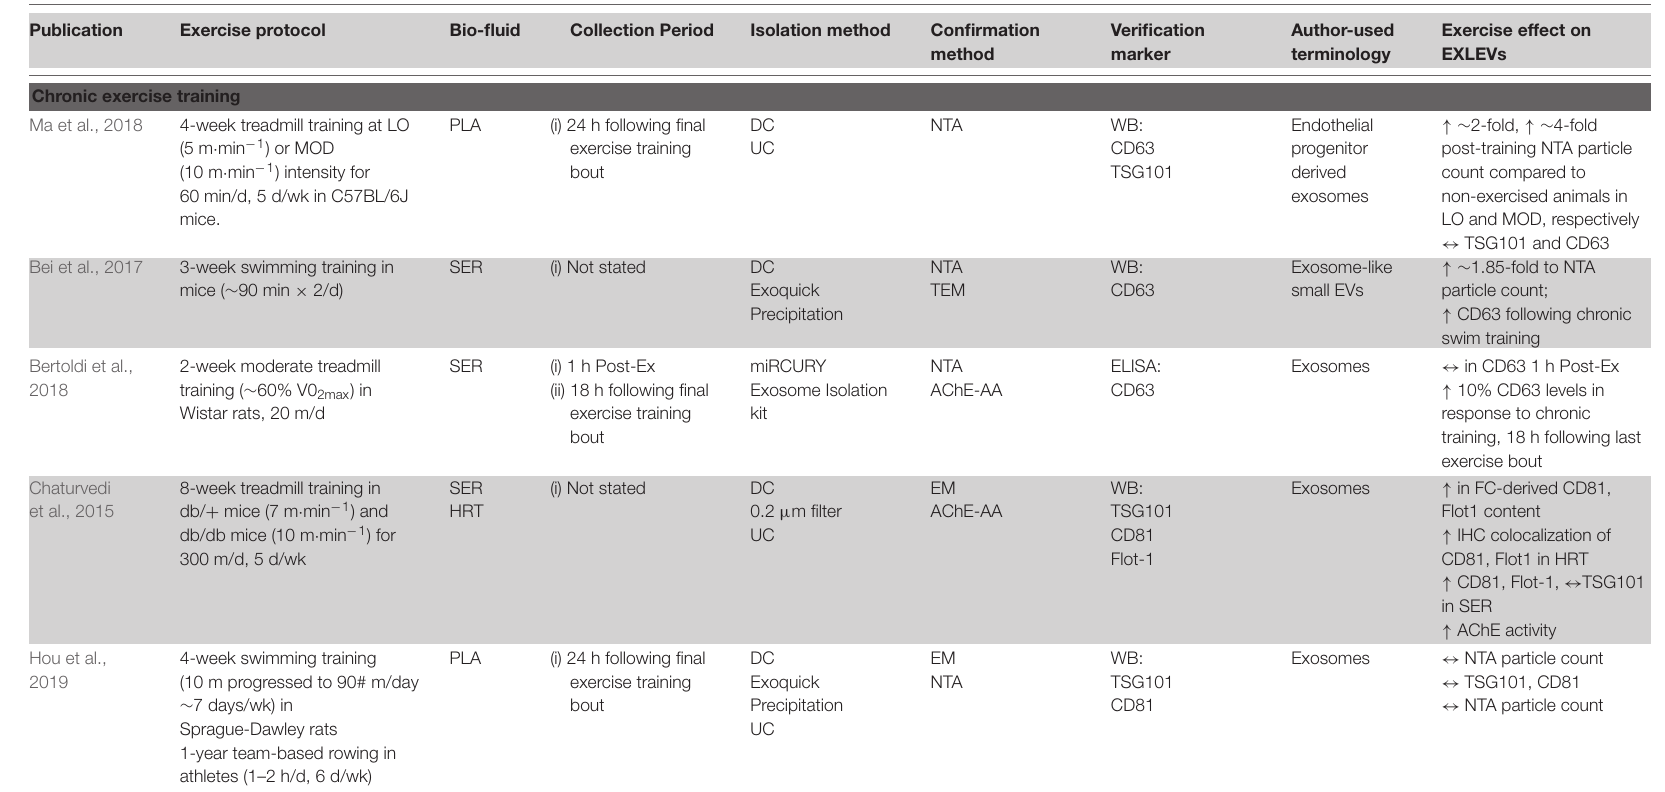
TABLE 2 | Effect of chronic exercise training on